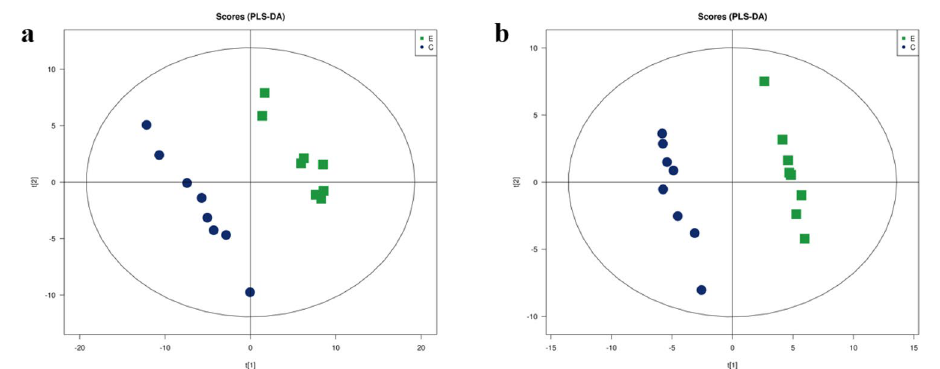
Figure 3. LC/MS based PLS-DA of rat myocardial samples from group C and group E. ( a ) Negative ions in group C/E, ( b ) positive ions in group C/E.